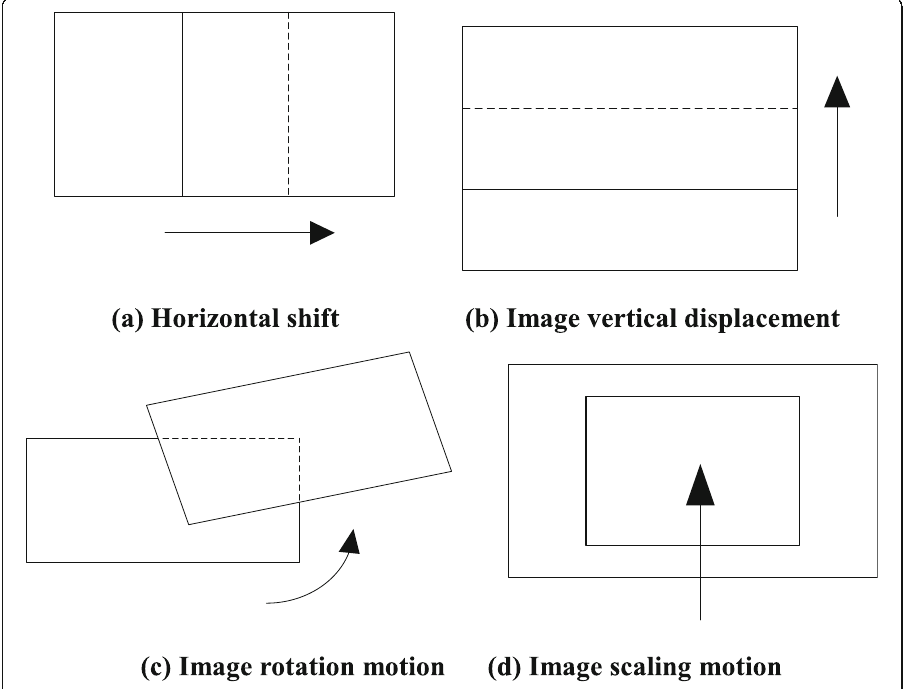
Fig. 1 Image global motion estimation model. a Horizontal shift. b Image vertical displacement. c Image rotation motion. d Image scaling